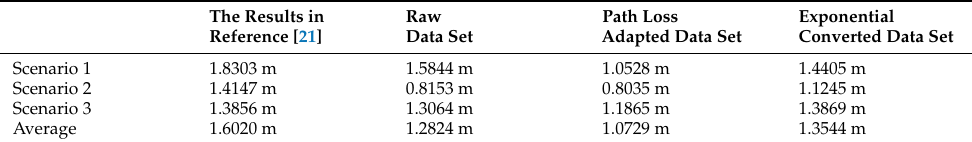
Table 5. Estimation accuracy of ANN in terms of